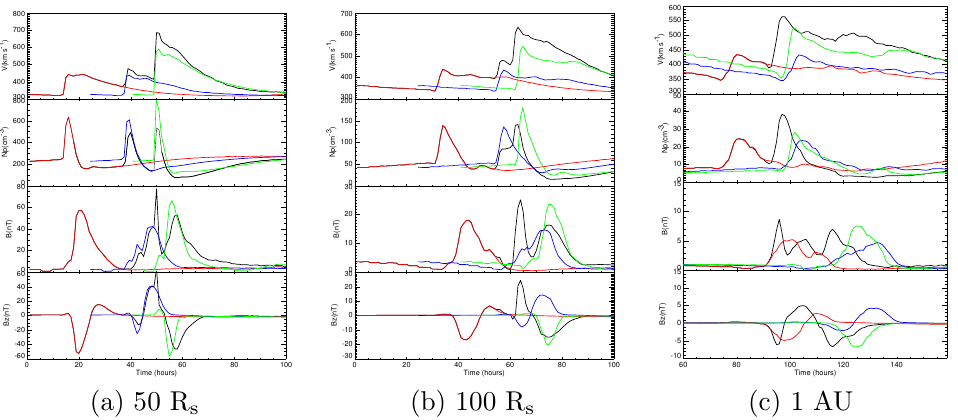
Figure 9. Profiles of velocity, density, magnetic field and south component of magnetic field as function of time at different heliospheric distances: ( a ) 50 R s ( b ) 100 R s and ( c ) 1 AU for CME1 (red), CME2 (blue), CME3 (green) and CME123